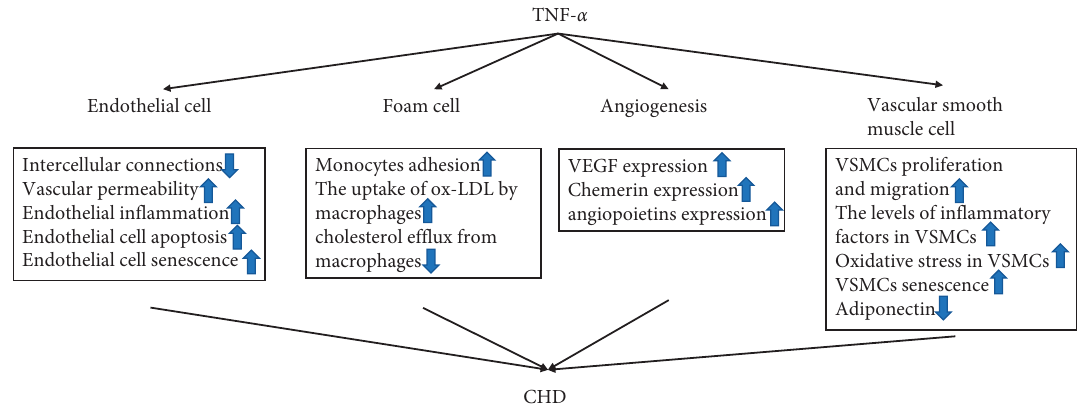
Figure 1: Specific mechanism of TNF- α in